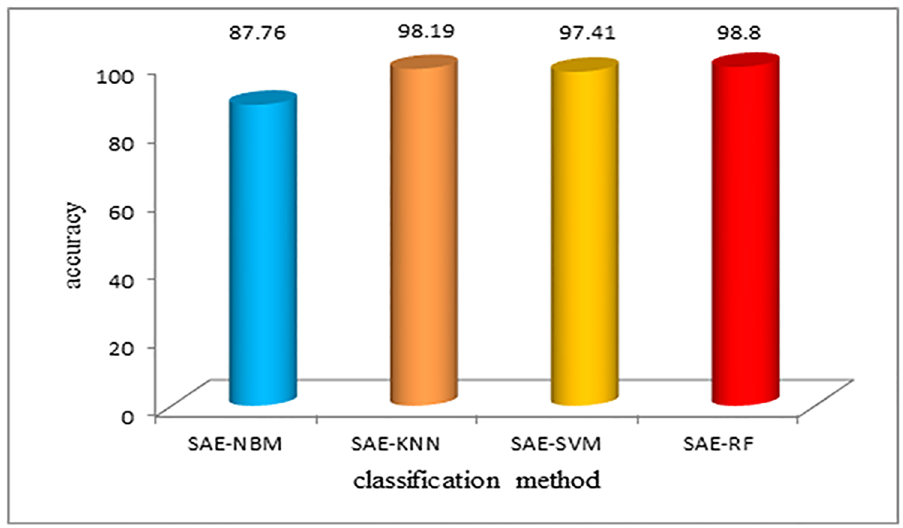
Fig 12. Classification accuracyusing different algorithms after SAE dimension reduction. Then SAE was appliedinto the data dimensionreduction, the accuracy of the classification result has been further improved, which is shown in Fig 12. And the SAE-RF algorithmimprovedalmost 0.5% comparedwith PCA-RF.